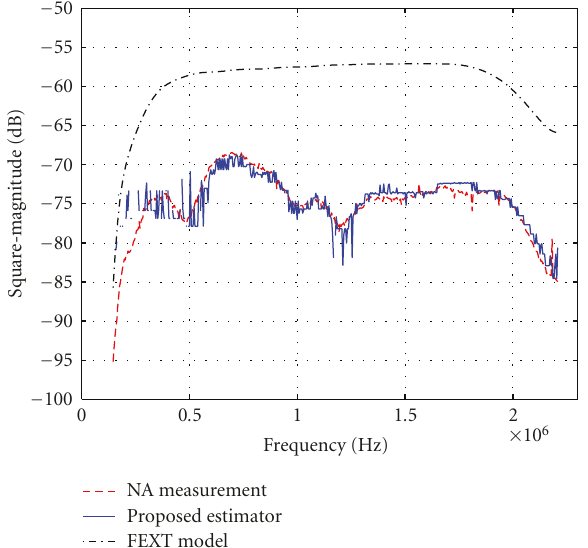
Figure 14: Square-magnitude of the lower (shorter) FEXT channel for access network scenario II obtained with the NA, the FEXT model, and the proposed estimator.